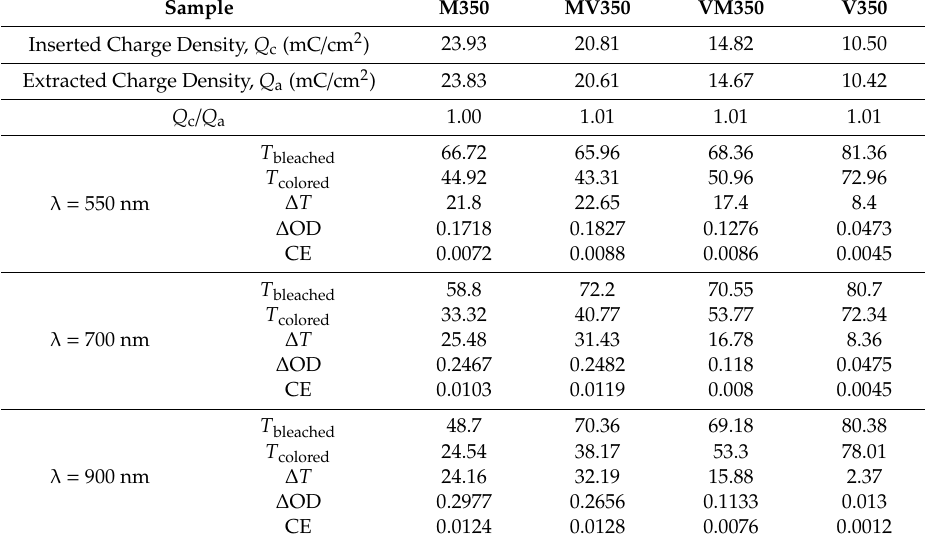
Table 2. Electrochromic properties of MoO 3 /V 2 O 5 hybrid nanobilayers heated at 350 °C for 2 h in air at the wavelengths 550, 700, and 900 nm, respectively. OD: optical density; CE: coloration efficiency.